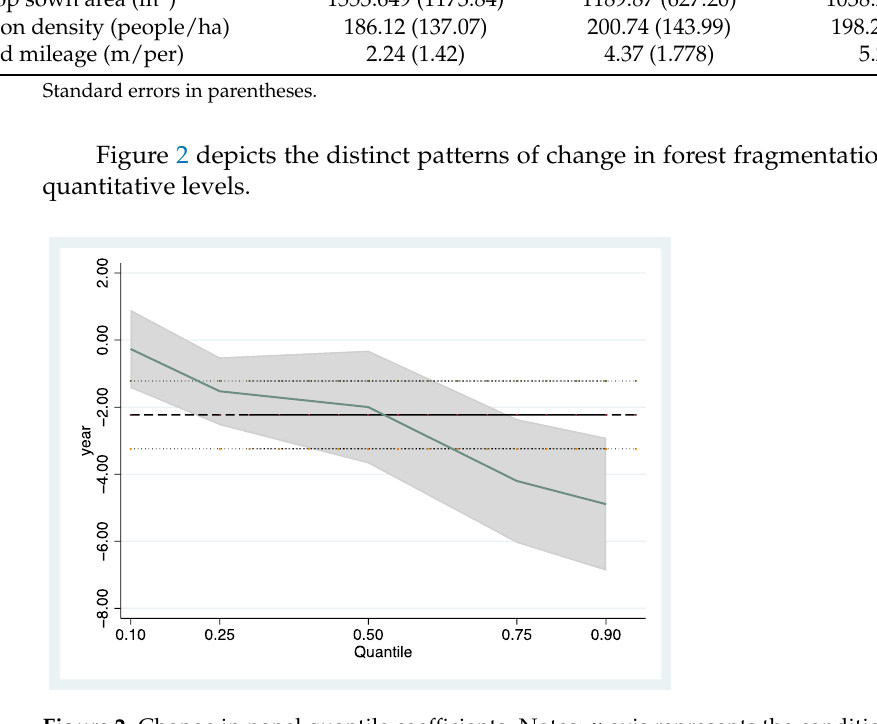
Figure 3. Changes in forest fragmentation in the Beijing – Tianjin – Hebei region, 2000, 2010, and 2018.